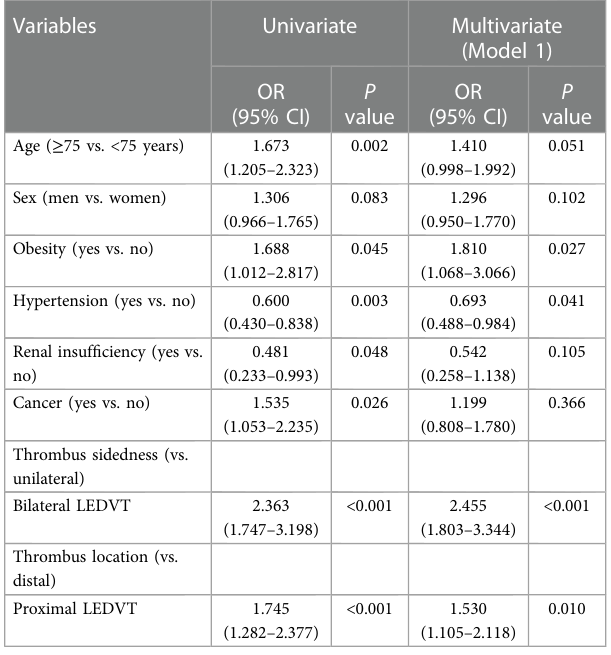
TABLE 3 Univariate and multivariate logistic regression analyses of factors associated with pulmonary embolism (Model 1). Variables